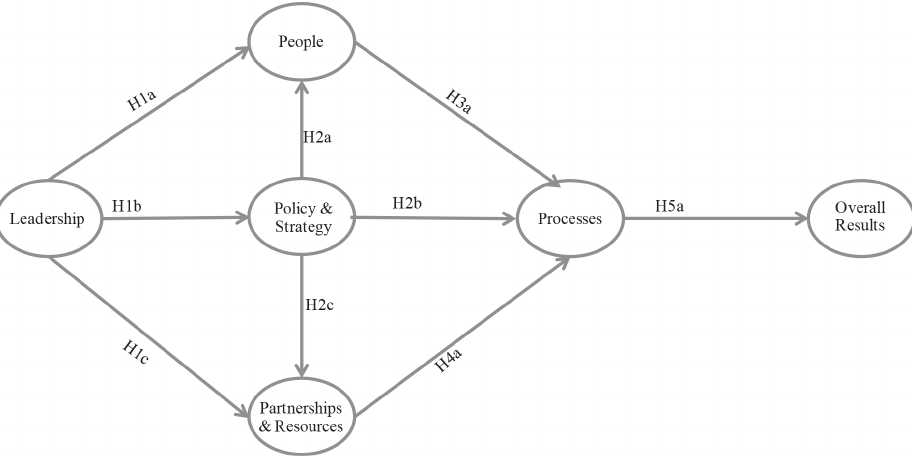
Fig. 1. Research model and